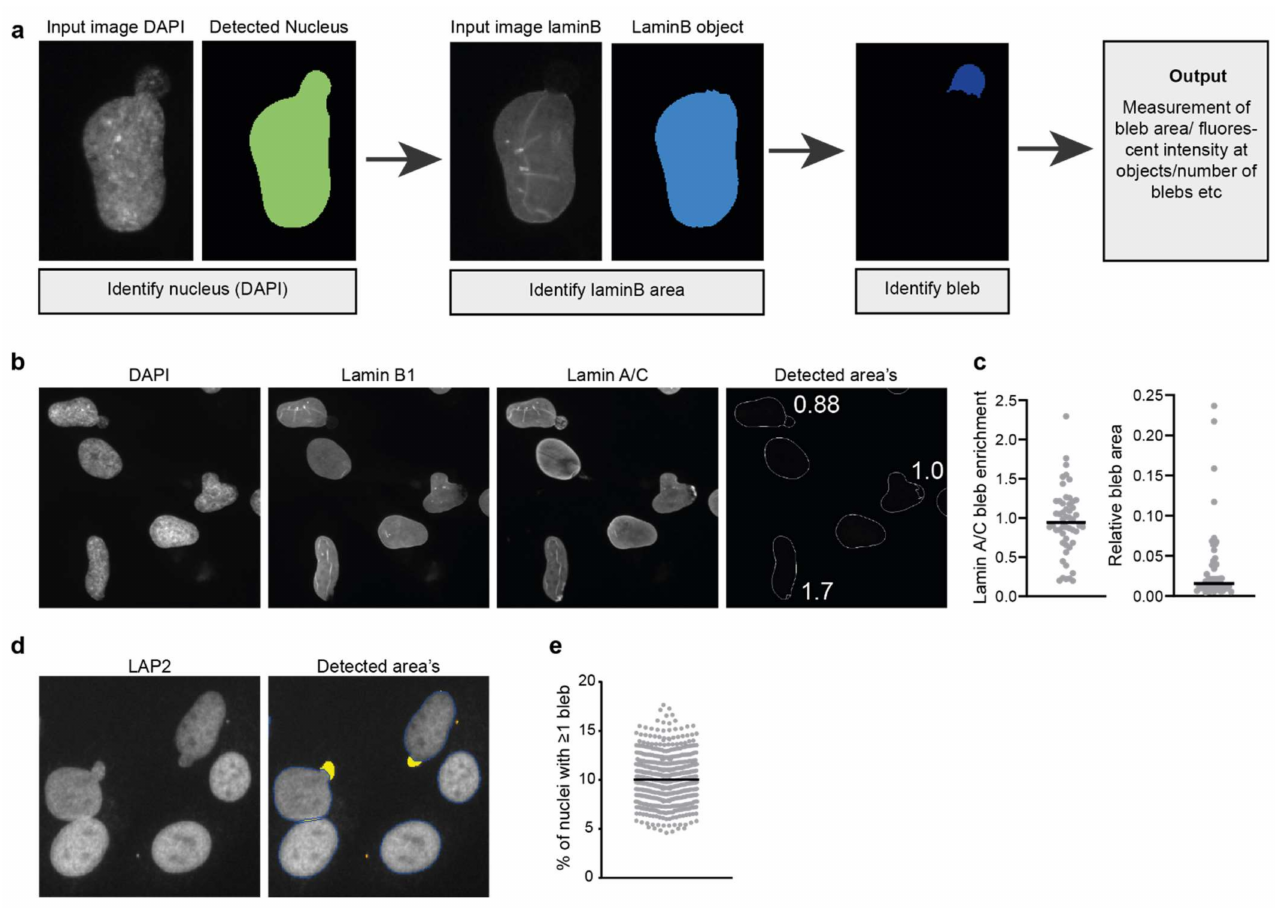
Figure 5. Detection and analysis of nuclear blebs. ( a ) Simplified pipeline and example showing the detection of nuclear blebs in CellProfiler. ( b ) Example image showing the endogenous staining of lamin B1 and lamin A/C in human fibroblast cells and the detected area’s using the pipeline described in ( a ). Numbers indicate the lamin A/C enrichment calculated for the detected blebs (laminA/C bleb /laminA/C laminBobject ) ( c ) Example showing the quantification of lamin A/C enrich- ment at blebs in human fibroblast and the relative bleb area (area bleb /area nucleus ) using the described pipeline. ( d ) Nuclear bleb detection in LAP2-stained nuclei in hTERT immortalised control fibroblasts in images acquired on a high-content microscope. The detection algorithm is based on the micronuclei detection algorithm (see text and Figure 3); however, the algorithm now selects nuclear blebs (yellow overlay) for analysis and rejects micronuclei (orange overlay) based on their size and distance to the primary nucleus (dark blue contour). ( e ) Quantification of nuclear bleb occurrence frequency in hTERT immortalised control fibroblasts in multiple biological replicates using automated nuclear bleb detection shown in ( d